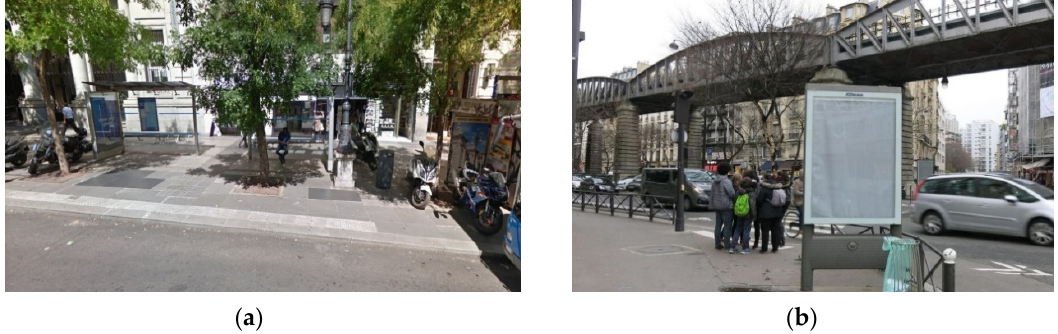
Figure 13. Two sample test images presenting undetected panels for SSD and YOLOv3: ( a ) complex scene; ( b ) panel without publicity.